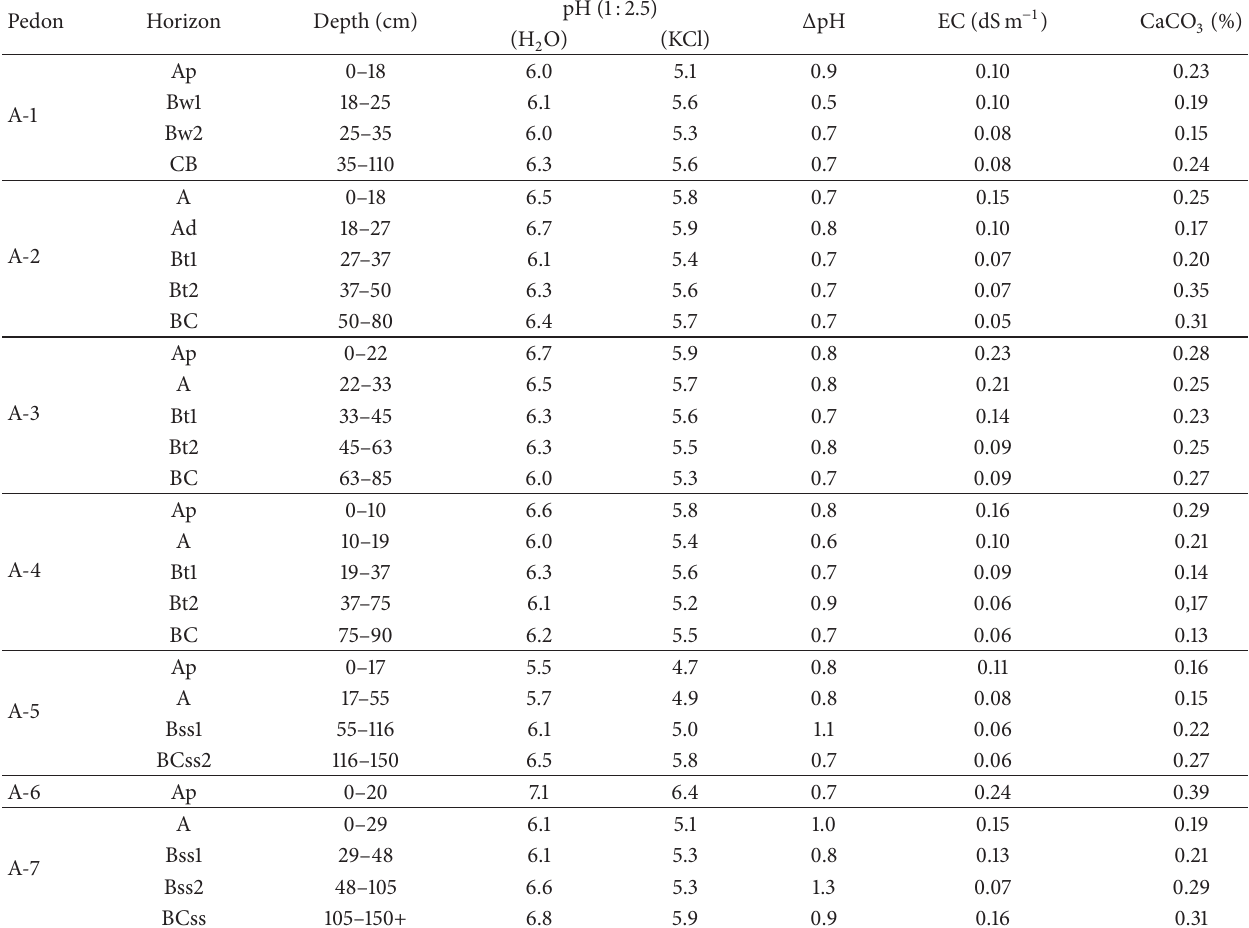
Table 6: Soil pH, electrical conductivity, and calcium